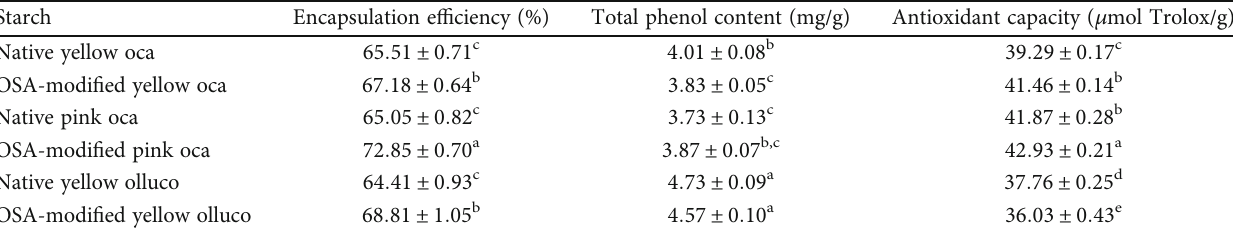
Table 1: Encapsulation e ffi ciency, total phenol content, and antioxidant capacity of purple mashua extracts spray dried with native and OSA-modi fi ed starches.